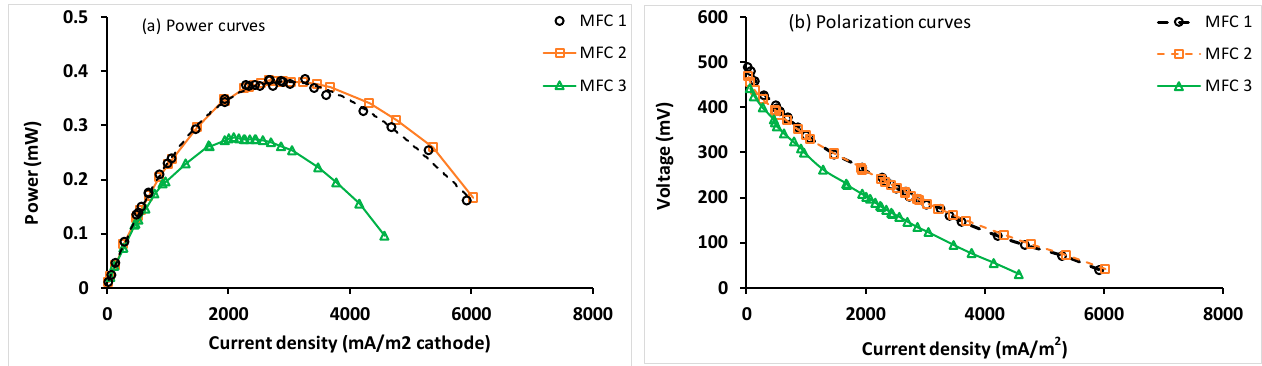
Figure 3. Performance of MFC 1, MFC 2, and MFC 3 individually: ( a ) power curves and ( b ) polarization curves.